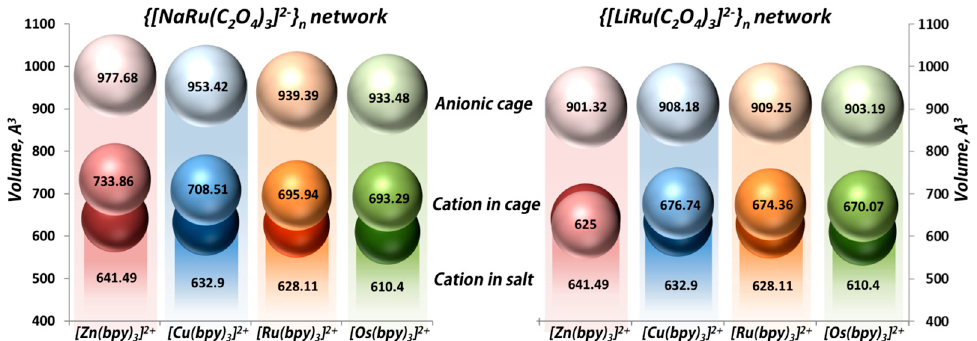
Figure 4. Representation of accessible volumes of anionic cages in {[NaRu(C 2 O 4 ) 3 ] 2 − } n ( right ) and networks {[LiRu(C 2 O 4 ) 3 ] 2 − } n ( left ), the volumes of [Z II (bpy) 3 ] 2+ (Z II = Zn 2+ , Cu 2+ , Ru 2+ ,Os 2+ ) cationic complexes in their salt forms (darker spheres) and incorporated in corresponding 3D polymeric nets (medium spheres). The volume calculation for the [Z II (bpy) 3 ] 2+ complex in salt forms has been performed using the published crystallographic data [86–89].